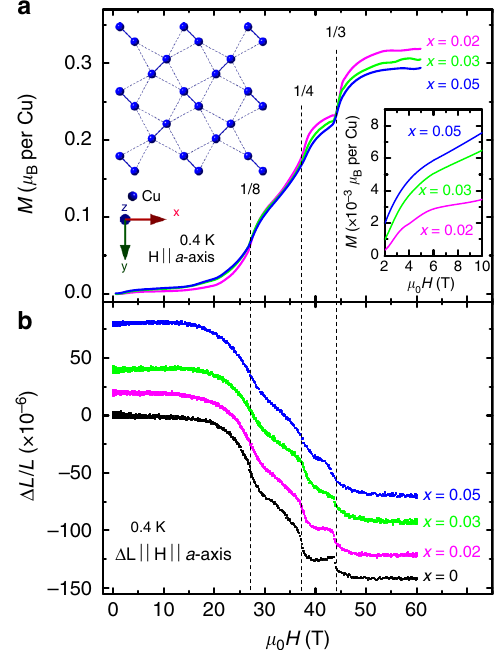
Fig. 1 Magnetization plateaus in Mg-doped SrCu 2 (BO 3 ) 2 . a Magnetization ( M ) vs. fi eld ( H ∥ a -axis) for x = 0.02 (magenta), 0.03 (green), and 0.05 (blue), and b magnetostriction ( Δ L / L ) vs. fi eld ( H ∥ a -axis) for x = 0 (black), 0.02 (magenta), 0.03 (green), and 0.05 (blue), at T = 0.4 K, conducted in a 65 T multi-shot magnet at the pulsed fi eld facility of the national high magnetic fi eld laboratory (NHMFL). Lower right inset: M ( H ) for the three dopings at low H , obtained from 60 T shots. Upper left inset: a schematic of the spin-1/2 Cu 2 + ions in the SS lattice, as realized in SrCu 2 (BO 3 ) 2 . Traces in ( b ) are shifted for